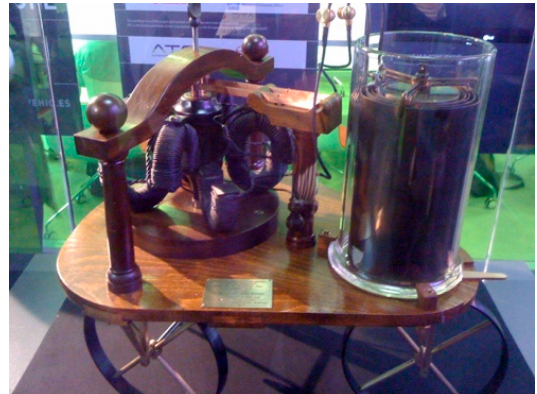
Figure 1. Replica of first 19th century scale model electric vehicle. Reproduced with permission from the Automotive Campus, Helmond, The Netherlands.